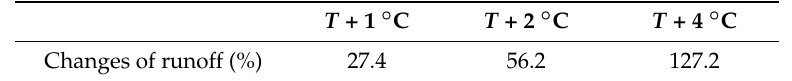
Table 5. Change of runoff under various changes of